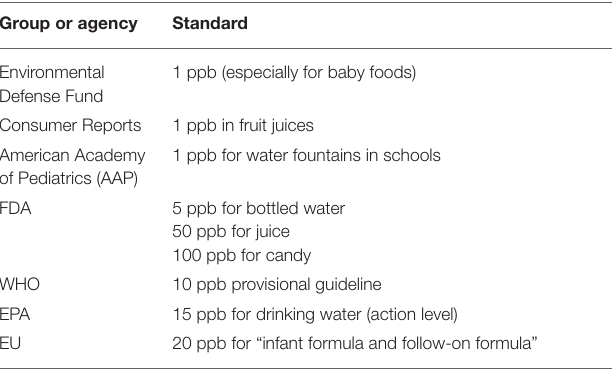
TABLE 3 | Proposed and existing lead standards. Group or agency